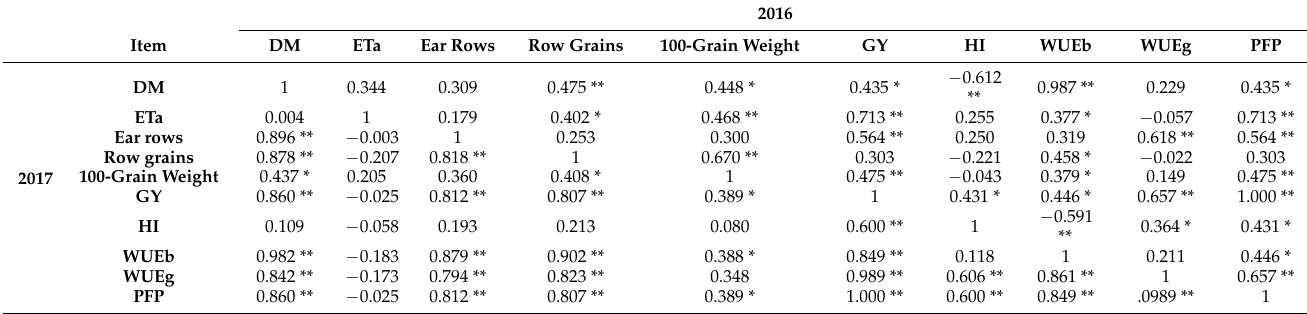
Table 7. Correlation coefficients between growth and yield parameters of the